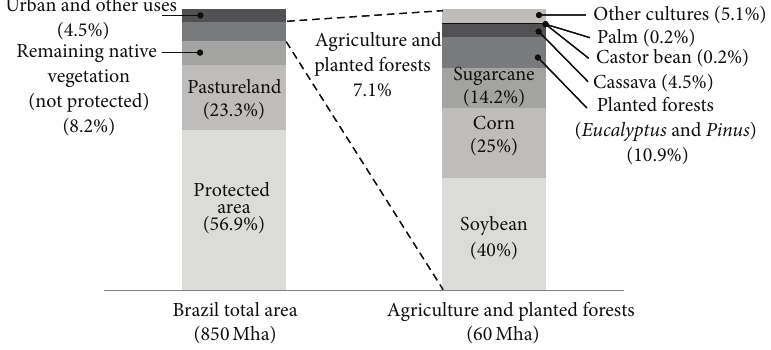
Figure 4: Land use and planted area with some potential biofuel feedstocks in Brazil [33,